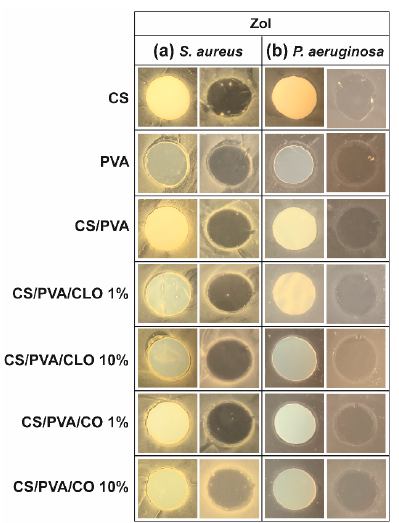
Figure 8. ZoI of unloaded and EO-loaded CS/PVA blended films while cultured with ( a ) S. aureus and ( b ) P. aeruginosa bacteria, up to 24 h. Images were collected without regard for size proportionality, being only used to reveal the halos formed. For each bacterium, left images depict films at their original location at the beginning of the assay, along with the bacteria that grew over the incubation period; while on the right, cultured films were carefully removed from the agar so that contact-kill could be